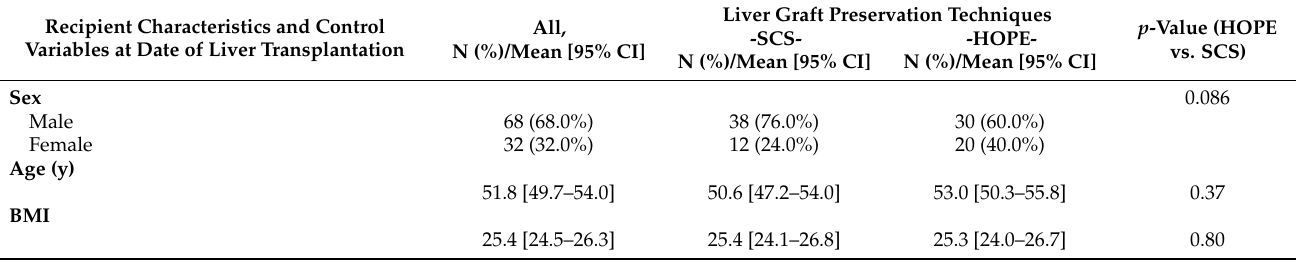
Table 2. Description of characteristics and key variables of liver transplant recipients stratified by liver graft preservation